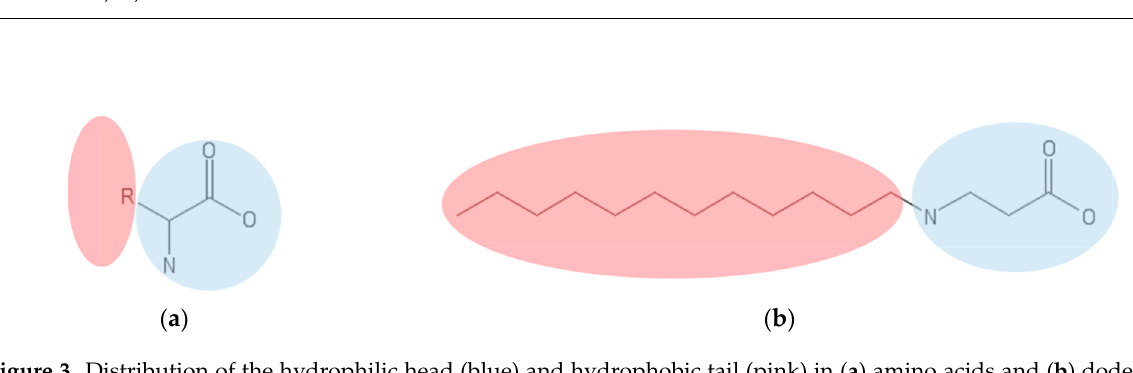
Figure 3. Distribution of the hydrophilic head (blue) and hydrophobic tail (pink) in ( a ) amino acids and ( b ) dodecyl- β - alanine. The hydrophilic head of both molecules have a similar chemical structure, but the amino acids have no surfactant activity while the dodecyl- β -alanine has the ability to reduce the tension of air–water interfaces.